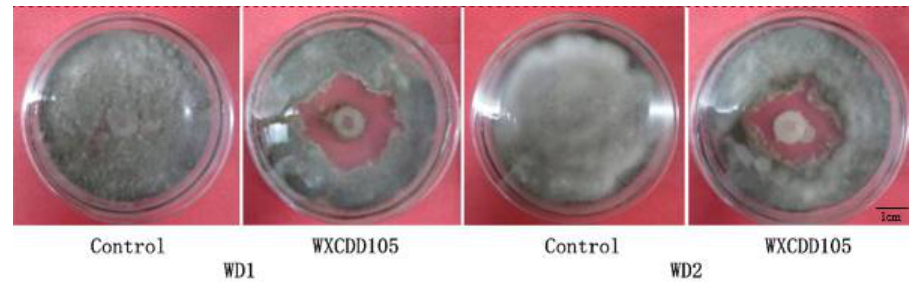
Figure 1. Antagonistic effects of strain WXCDD105 against Botrytis cinerea WD1 and Cladosporium fulvum Cooke WD2.